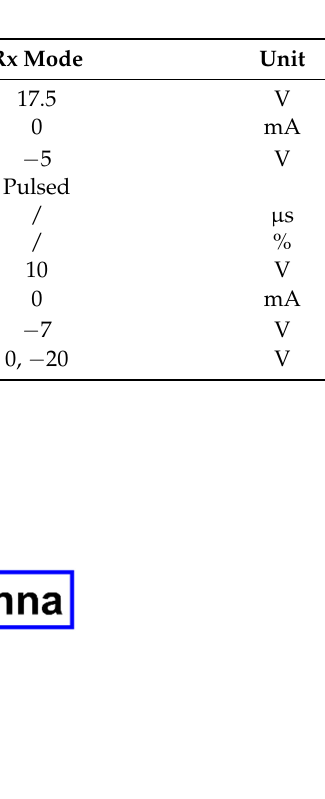
Figure 3. Test fixture for the characterization of the prototype of the SCFE.